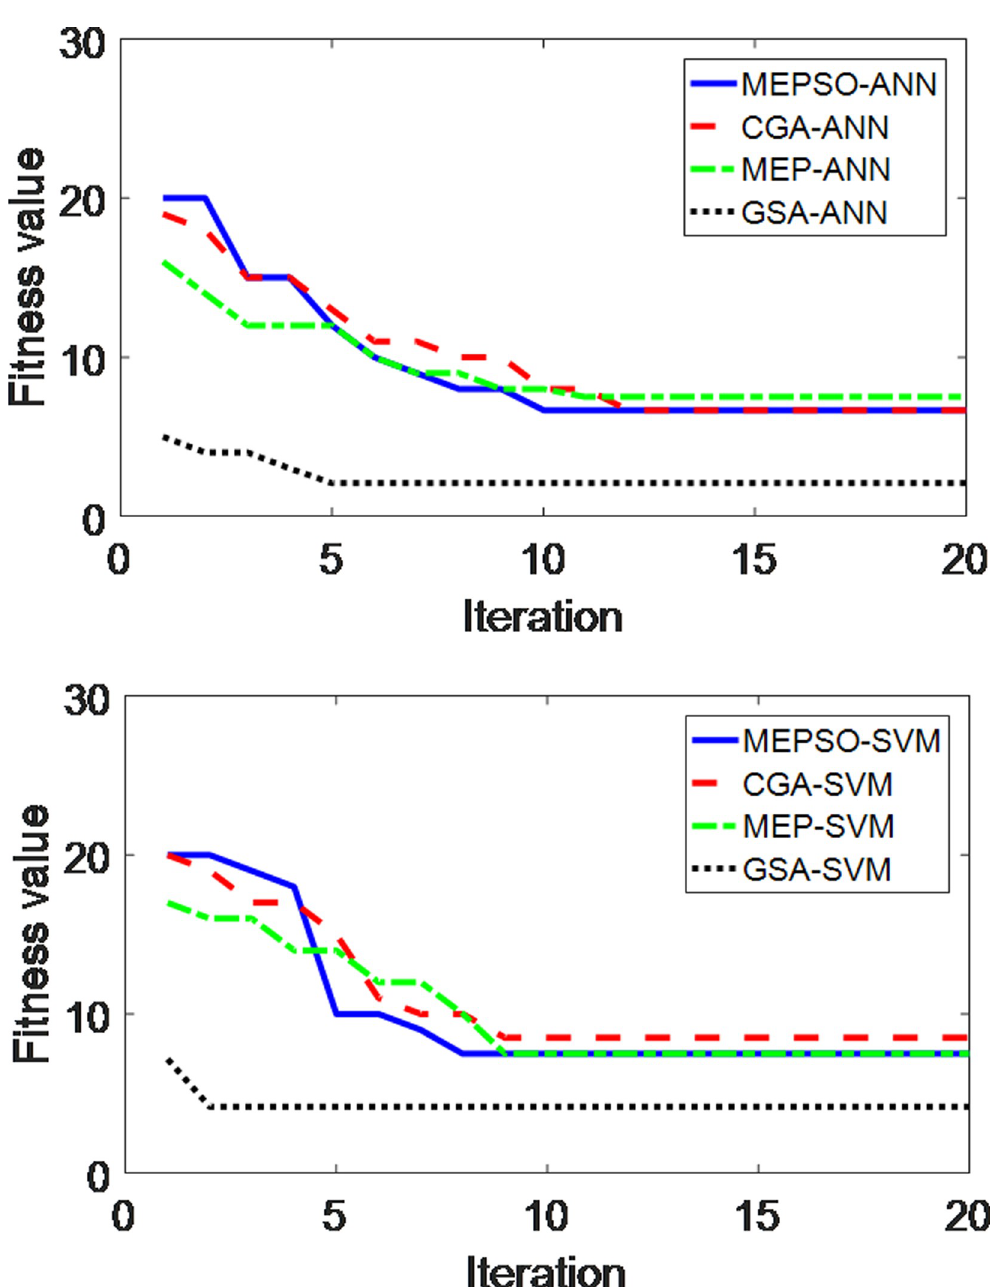
Fig 5. Convergence curve of different algorithms combined with (a) ANN and (b) SVM using 70:30 ratio for training and testing data. than GSA-ANN. Comparison between GSA-AI, chaotic genetic algorithm (CGA)-AI, modi- fied evolutionary programming (MEP)-AI and modified evolutionary particle swarm opti- mization (MEPSO)-AI shows that GSA-AI achieves higher accuracy and has faster convergence than the other optimization techniques. A non-parametric statistical test based on McNemar’s test shows a significant difference exists in the results found between the proposed method and the other methods. Therefore, the proposed hybrid GSA-AI methods